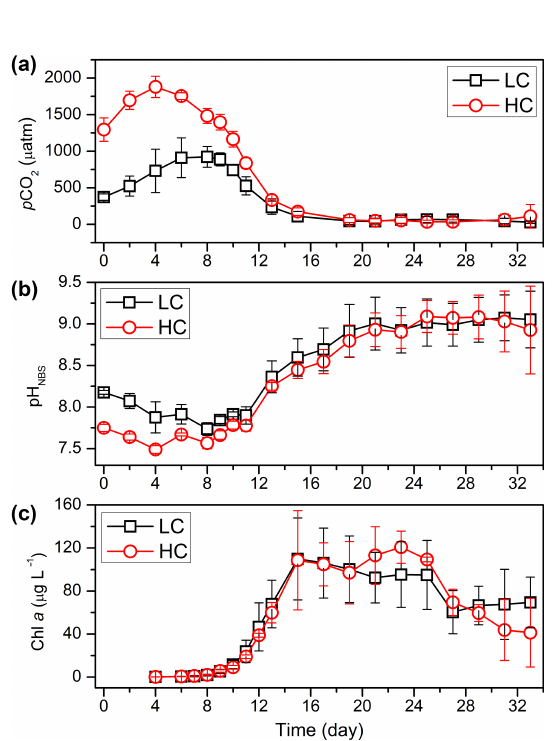
Figure 1. Temporal variations of p CO 2 (a) , pH NBS (b) and Chl a (c) during the whole experiment. The p CO 2 was calculated from DIC and pH using the CO2SYS program. Data are the means ± SD, n =